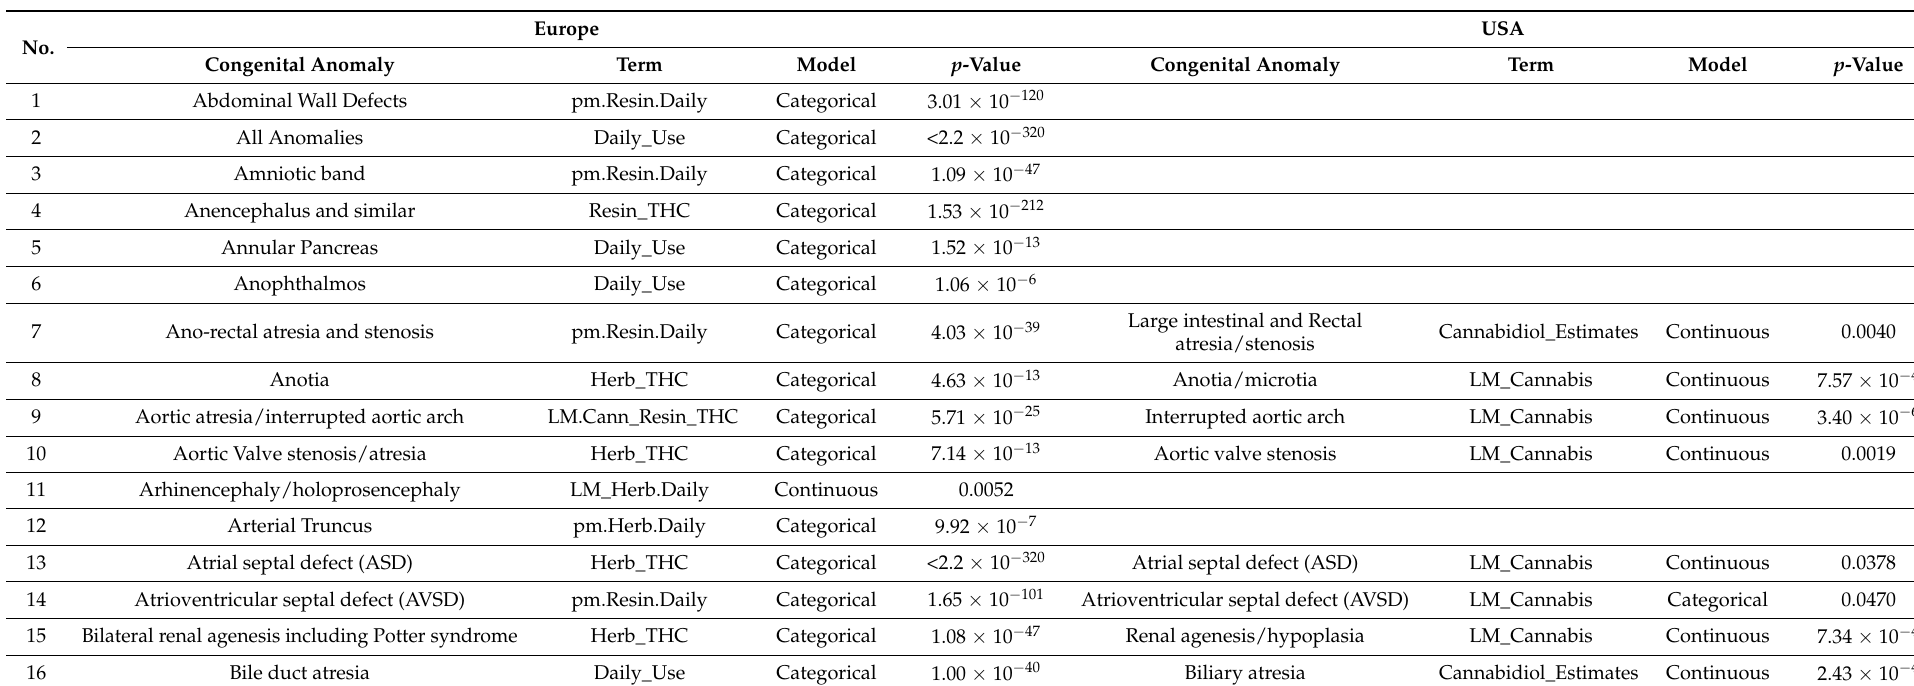
Table 6. Comparative Lists of Significantly Cannabinoid-Associated Congenital Anomalies in Europe and